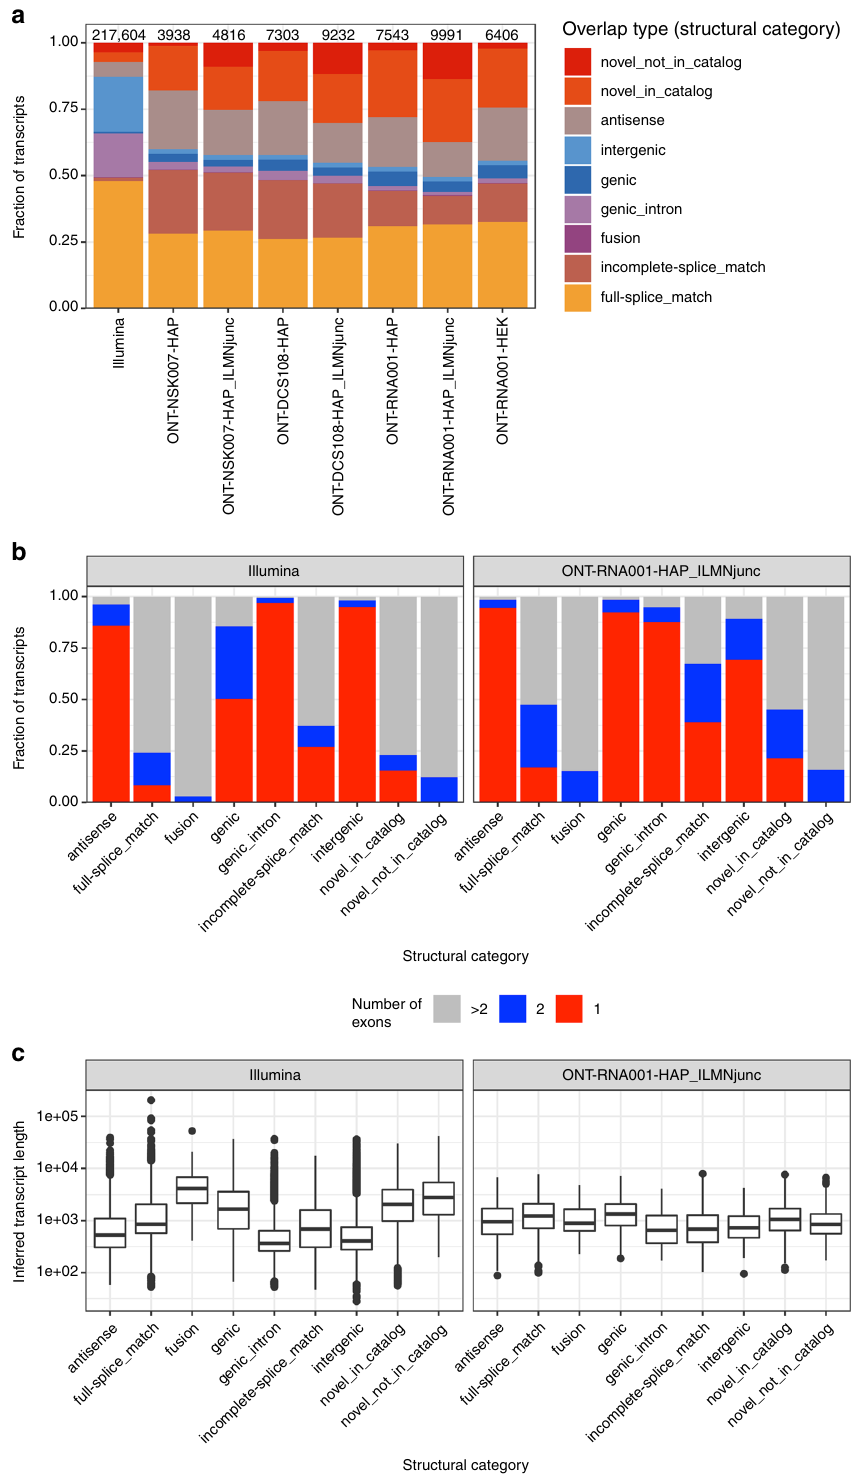
Fig. 6 Characterization of transcripts identi fi ed by FLAIR. a Structural category distribution for de novo identi fi ed transcripts from FLAIR (for ONT libraries) or StringTie (for Illumina libraries), compared with the set of annotated transcripts using SQANTI. The number above each bar represents the number of assembled transcripts. The structural category for a transcript indicates its relation to the closest annotated transcript. The _ILMNjunc suf fi x indicates that junctions identi fi ed in the Illumina libraries were supplied when running FLAIR. b Number of exons in each transcript identi fi ed by FLAIR/StringTie, strati fi ed by the relation to the annotated transcripts (represented by the assigned structural category). c Length distribution of transcripts identi fi ed by FLAIR/StringTie, strati fi ed by the relation to the annotated transcripts (represented by the assigned structural category). The center line represents the median; hinges represent fi rst and third quartiles; whiskers the most extreme values within 1.5 interquartile range from the box. Source data for panels a , b are provided as a Source Data fi le